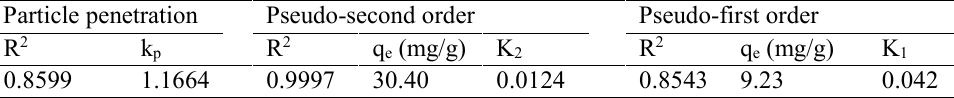
Table 5. The calculated parameters of pseudo-first order, pseudo-second order and particle penetration according to adsorbent type for MCPAC Particle penetration Pseudo-second